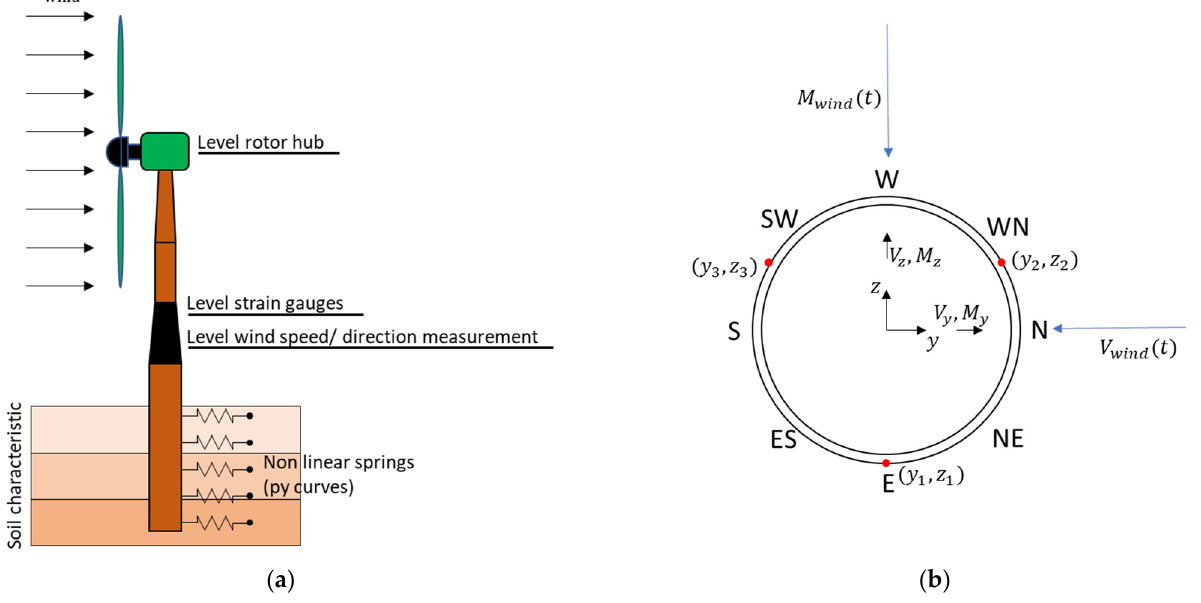
Figure 7. ( a ) Schematic representation of the wind turbine, ( b ) wind directions relative to the global coordinate system, with marked shear force, V wind , and moment, M wind , when the wind direction is northerly in the cross-section of the strain gauges.